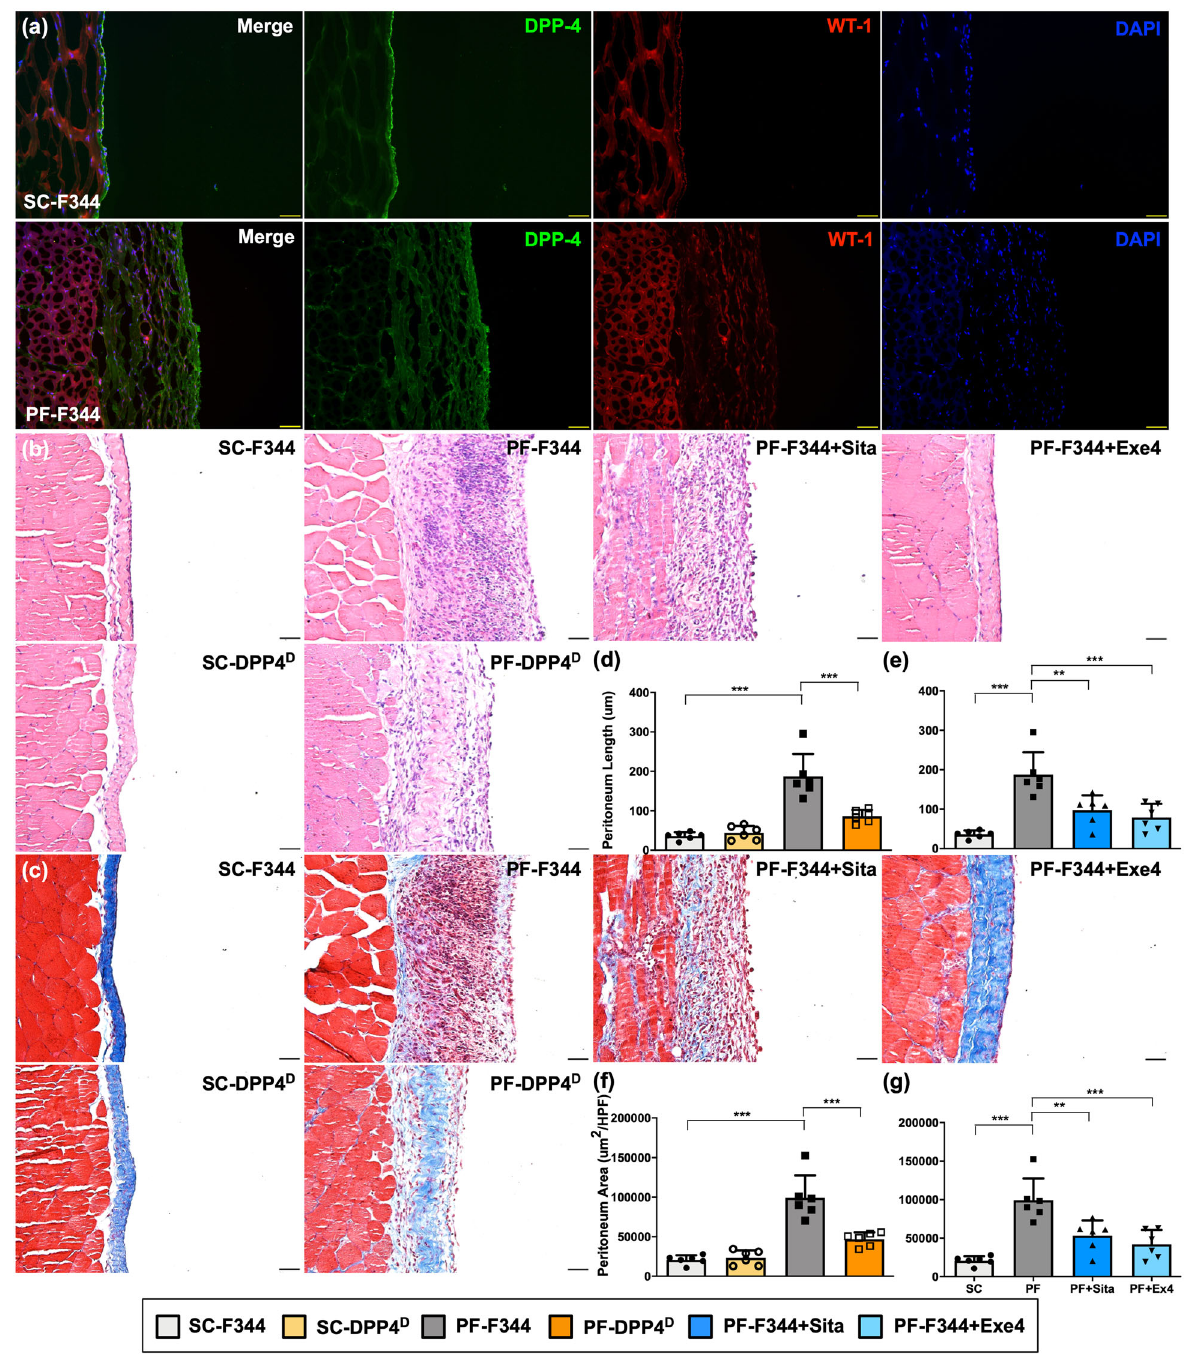
Fig. 4 DPP4 de fi ciency, sitagliptin, and exendin-4 protected peritoneum against CG-inducing peritoneal fi brosis in rats. The experimental model of peritoneal fi brosis (PF) was established by chlorhexidine gluconate (CG) induction for 21 days in wild-type (i.e., Fischer 344) and DPP4 de fi cient (DPP D ) rats. a Representative images of peritoneal tissue on day 21 were detected by immuno fl uorescent staining (200×) in SC-F344 (sham control, F344 wild type) and PF-F344 (peritoneal fi brosis, F344 wild type) rats for determining DPP4 (green color) and WT-1 positive signal (red color). DAPI labels cellular nuclei (blue color). b Histology of the peritoneum was observed by hematoxylin and eosin staining (H&E staining) in all the groups after CG-inducing PF. c Illustrating fi nding of Masson ’ s trichrome stain (200×) for identi fi cation of peritoneal fi brosis. d Quantitative result of peritoneal length by Masson ’ s trichrome stain in SC-F344, SC-DPP4 D , PF-F344, and PF-DPP4 D . e Quantitative result of peritoneal length by Masson ’ s trichrome stain in SC-F344, PF- F344, PF-F344 + Sita (sitagliptin), and PF-F344 + Exe4 (exendin-4). f , g Quantitative result of peritoneal area by Masson ’ s trichrome stain in each group. n = 6 for each group. Data represents the analysis and shows mean ± SD. Scale bars: 50 μ m; HPF: high-power fi eld. ** indicates p -value <0.01; *** represents p -value